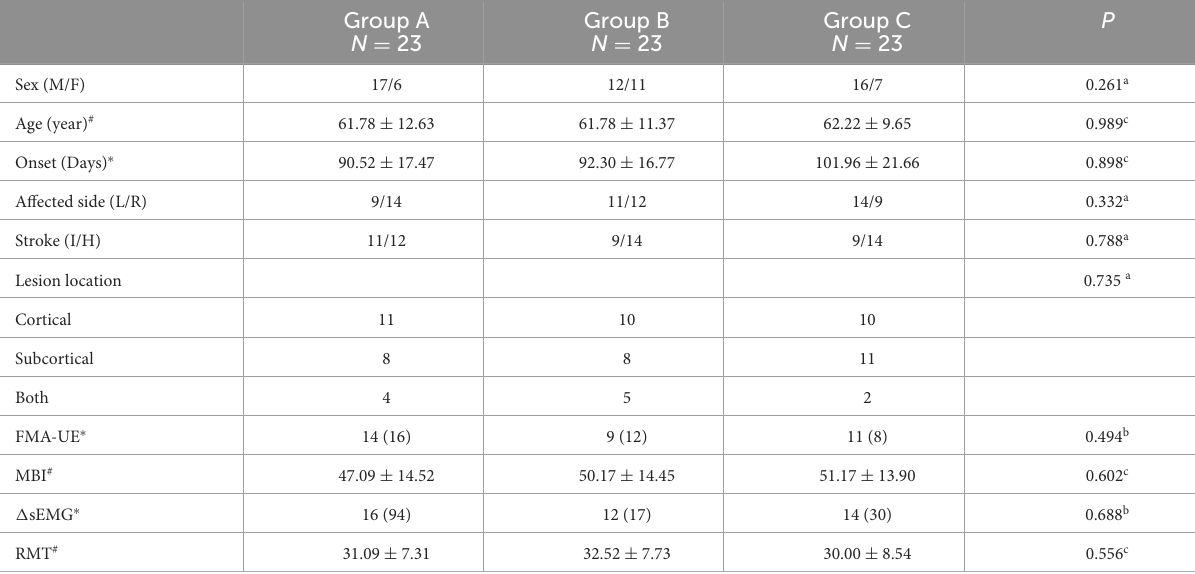
TABLE 1 Demographic and clinical